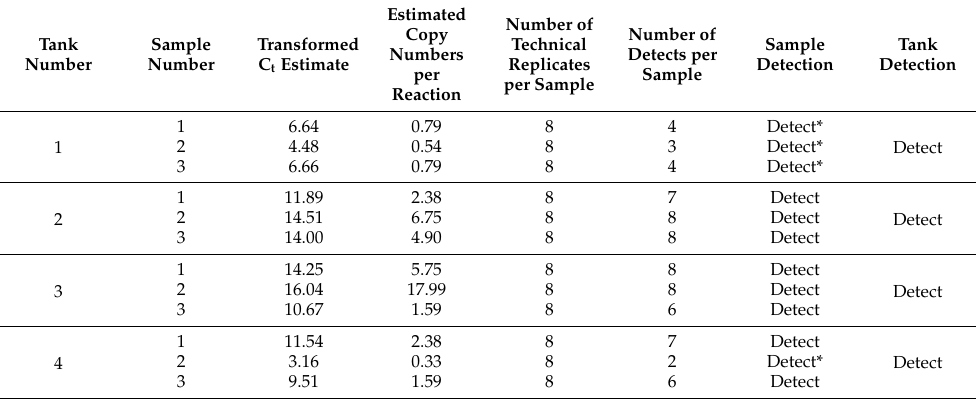
Table 6. The interpretation of Detect or No Detect of coho salmon DNA using the eONKI4 assay in the dilution experiment at the Goldstream Hatchery in the presence of an environmental background eDNA signal for the 40 kL dilution volume only. Several Detect* were found at the sample level, which suggest that target DNA may be present, but more sampling is recommended to confirm the result. The remaining samples in each tank at 40 kL were also assessed as either Detect or Detect*, which leads to a tank level conclusion of Detect for all